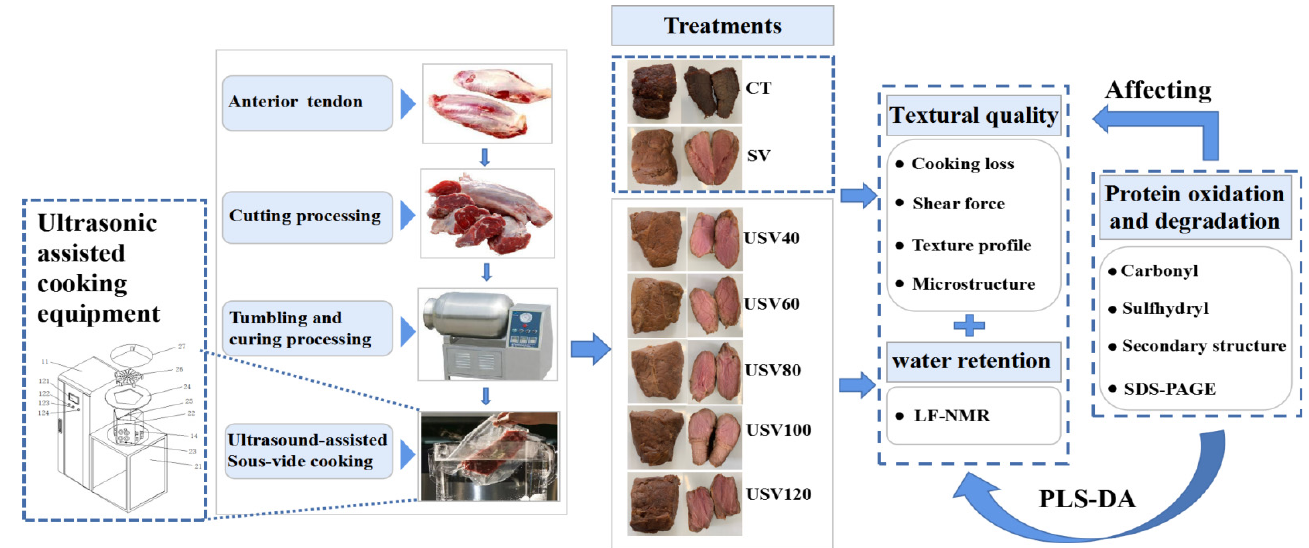
Figure 1. Flow chart of processing of spiced beef under different thermal treatments. CT: conventional cooking methods of spiced beef; SV: sous-vide cooking of spiced beef; USV40~USV120: ultrasound-assisted sous-vide cooking of spiced beef for 40~120 min.